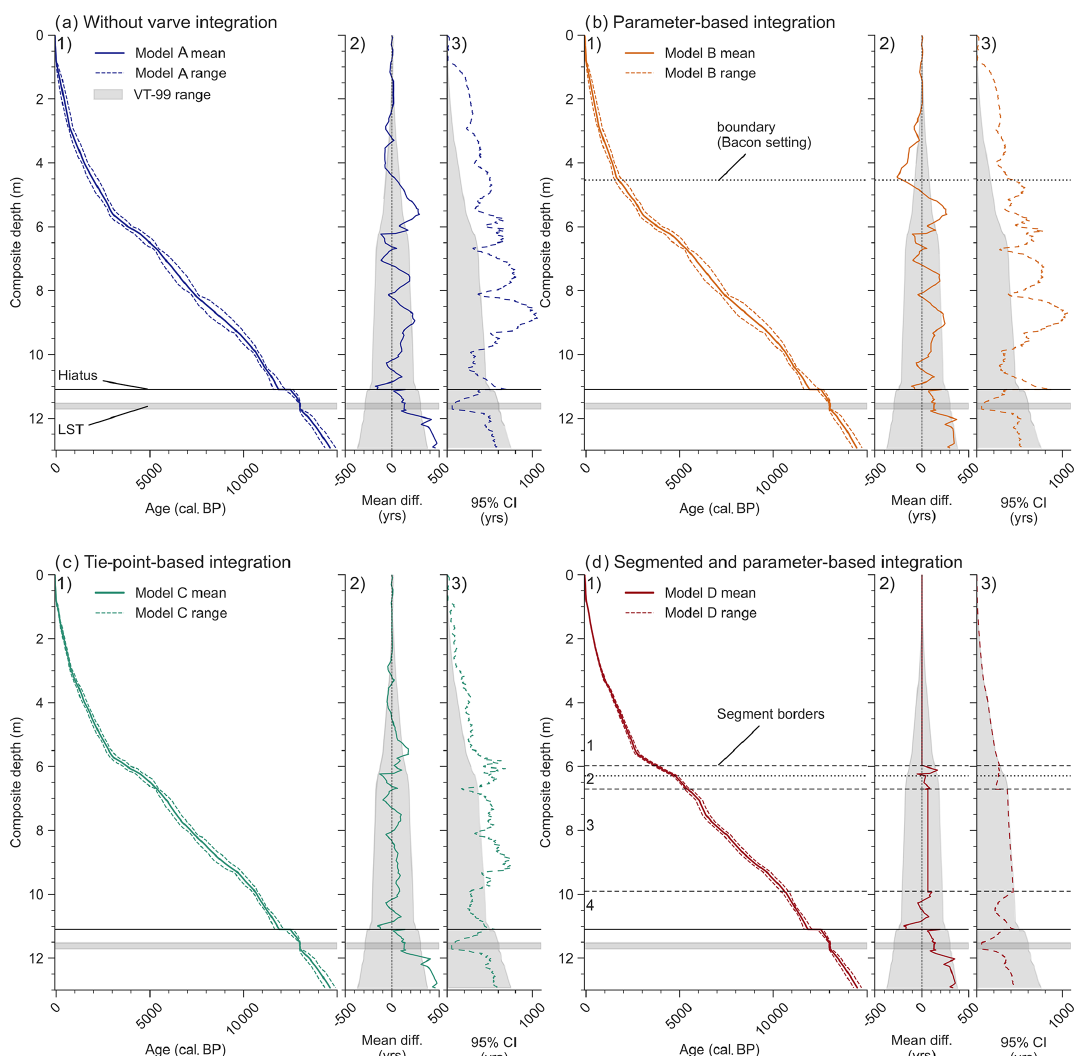
Figure 7. Results of Models A (a) , B (b) , C (c) , and D (d) plotted against composite depth (1) , compared to VT-99 as the difference in mean ages (model mean–VT-99 mean) (2) , and plotted vs. VT-99 confidence intervals (CIs) (3)